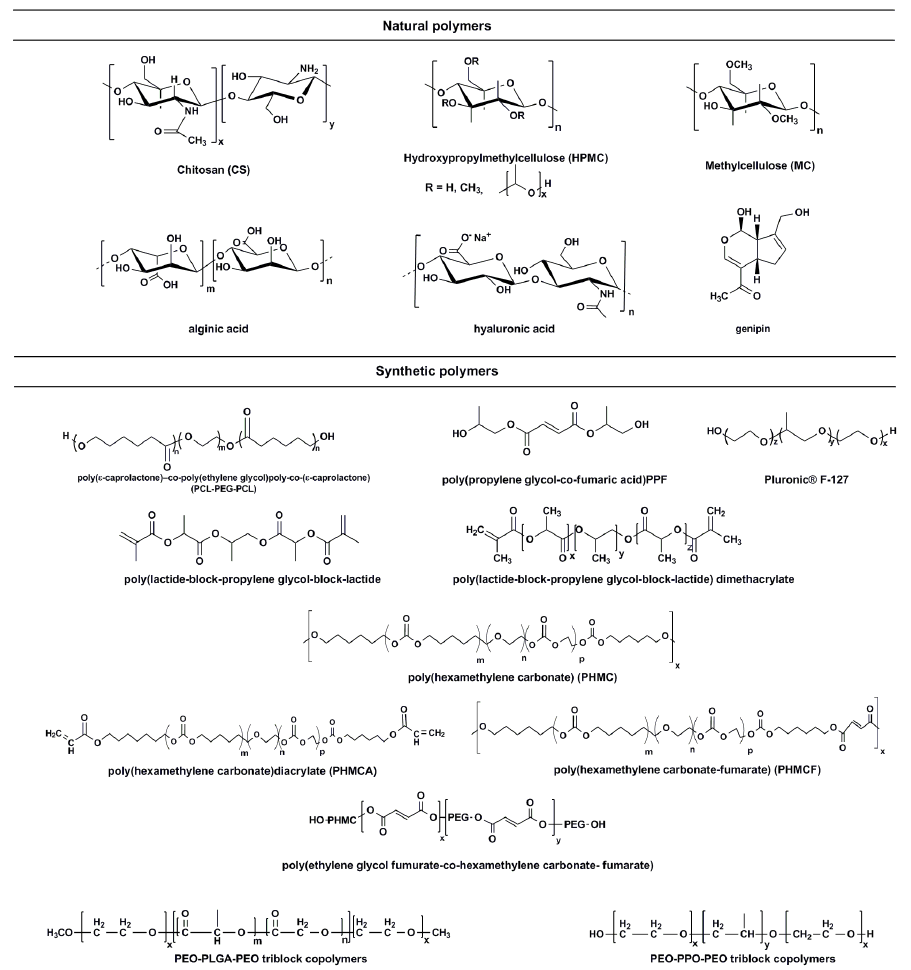
Figure 4. Chemical structures of selected most commonly used thermo-responsive polymers discussed in application for drug and tissue engineering (adapted with permission from Matanovic et al., 2014.